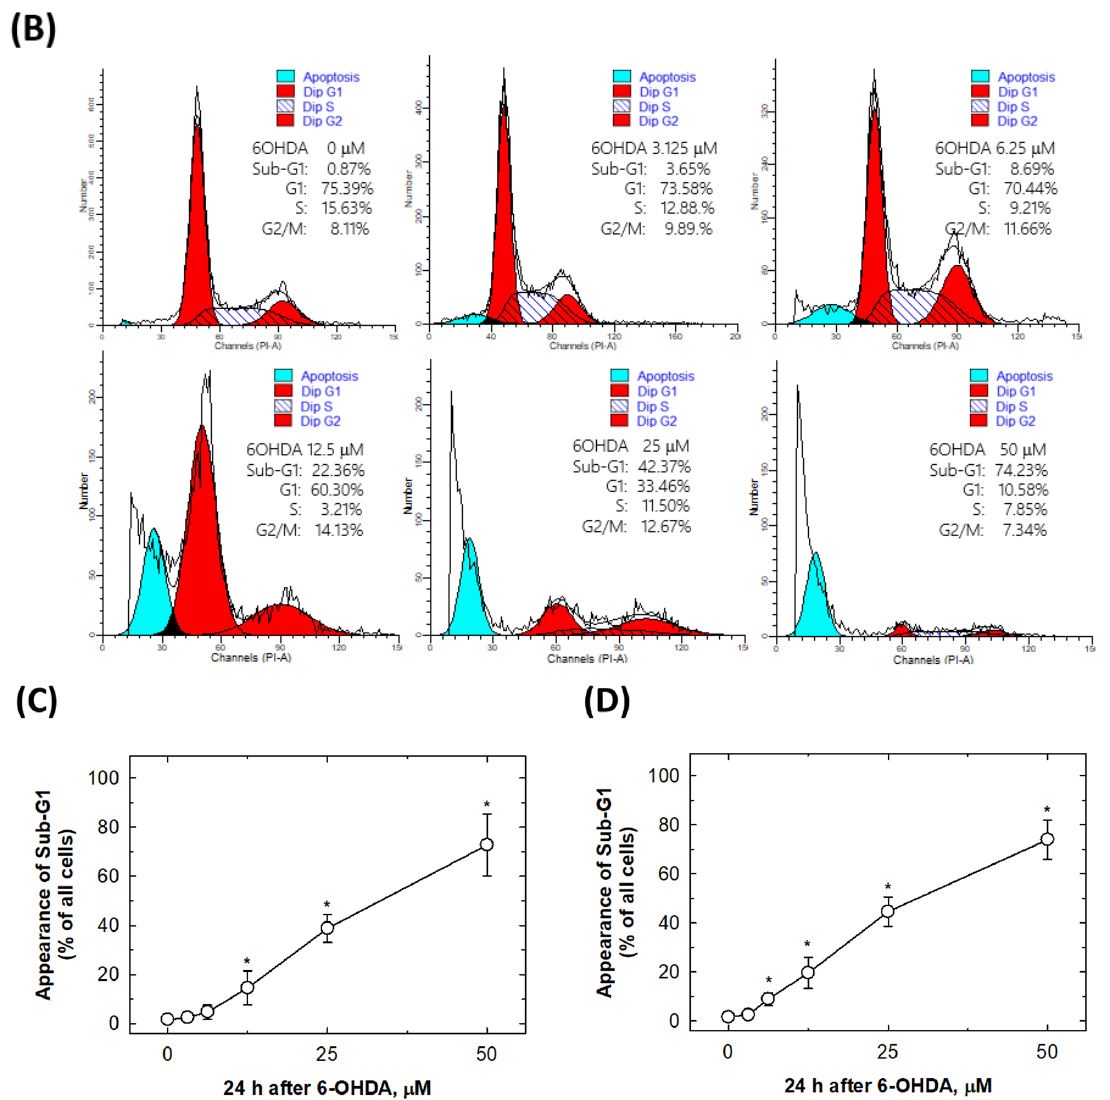
Figure 4. 6-OHDA dose-dependently induced apoptosis in SH-SY5Y and SK-N-SH cells. ( A ) After treatment with 6-OHDA at the indicated concentrations, SH-SY5Y cells were harvested, stained with propidium iodide (PI), and analyzed by flow cytometry. ( B ) After treatment with 6-OHDA at the indicated concentrations, SK-N-SH cells were harvested, stained with PI, and analyzed by flow cytometry. ( C ) The effect of 6-OHDA on SH-SY5Y cell apoptosis. ( B , D ) Effects of 6-OHDA on SK-N-SH cell apoptosis. * Statistically significant compared with the untreated group. Each experiment was repeated at least six times.